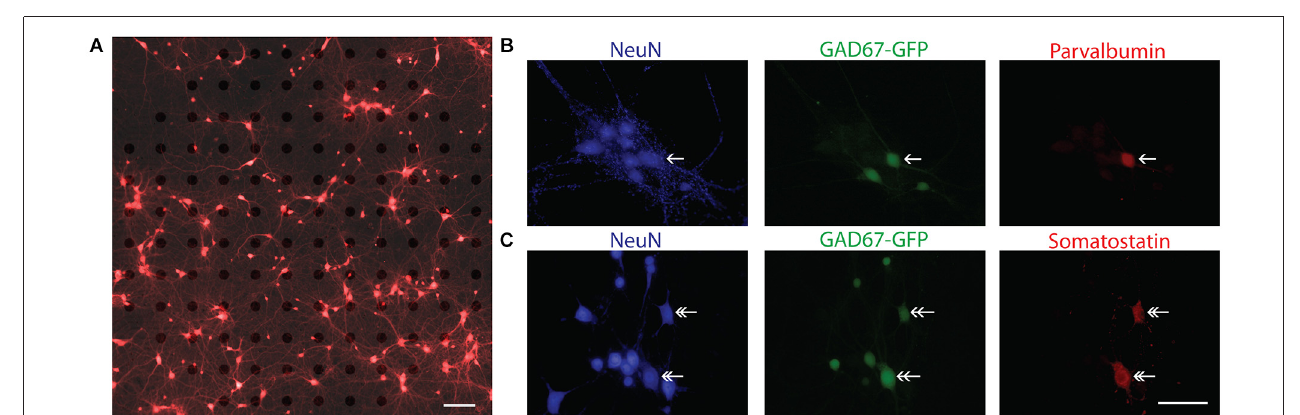
from 12 electrodes were detected. Scale bar is 100 µ m. (B,C) Immunocytochemistry confirms the presence of parvalbumin positive (single arrow head) and somatostatin positive (double arrow head) neurons. In (B) , NeuN (blue), GAD67-GFP (green), parvalbumin (red). In (C) , NeuN (blue), GAD67-GFP (green), somatostatin (red). Scale bar is 50 µ